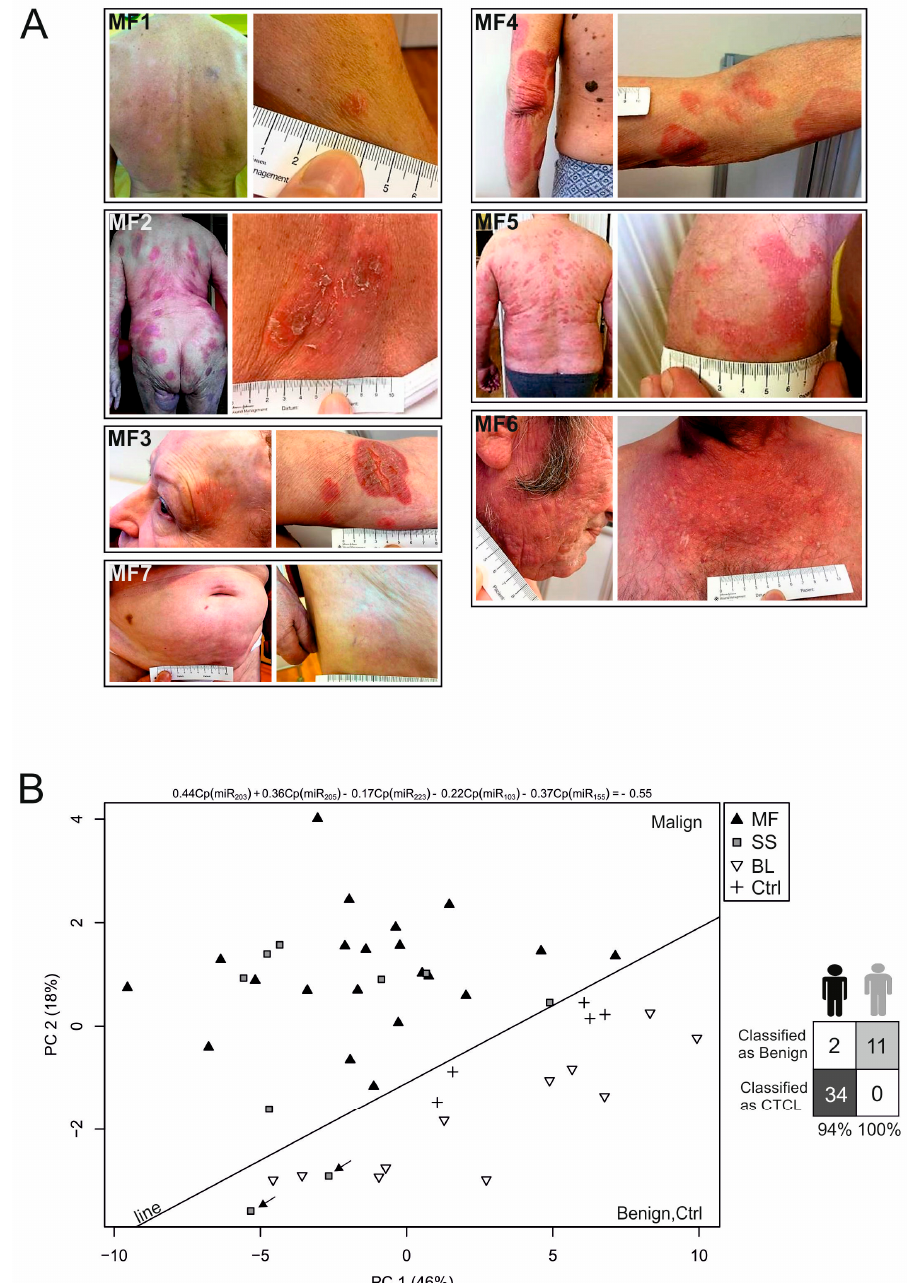
Figure 1. CTCL-MF patients and miR-classifier for CTCL plasma. ( A ) Photographs of the lesions in MF patients (MF1-7). Each panel shows a larger view of the lesion and its detail; ( B ) Principal component analysis (PCA) analysis of the miR-classifier in CTCL, benign lesions (BL) and healthy donors using expression data of miR-155, miR-203, miR-205, miR-22, miR-223, miR-103, and miR423-5p. A line separating the CTCL from BL is defined in the Results section. MF: dark triangle, SS: grey rectangle, BL: empty triangle, and controls are indicated by a cross. The arrows indicate two CR samples of one patient. ( B ) Right: classification performance in the training set using the progressive sampling algorithm called NSC (specificity 100%, sensitivity 94%) in which the dark field represents samples correctly diagnosed as malignant, the grey field represents samples correctly diagnosed as benign, and empty fields represent samples that are falsely diagnosed. Dark person icon: CTCL; grey person icon: BL.